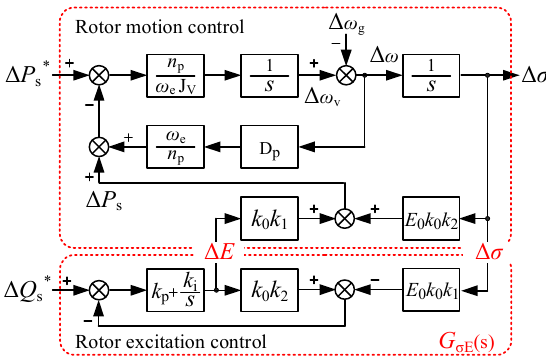
Figure 3. Active power regulation per unit power angle for different power-angle conditions.